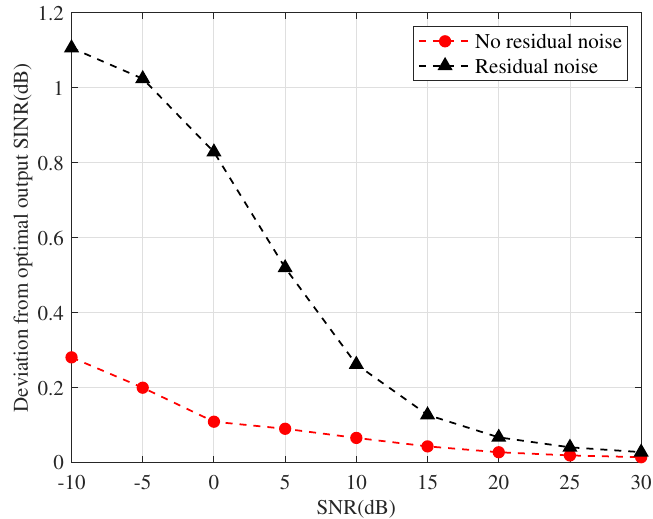
Figure 9. Deviation from optimal SINR versus input